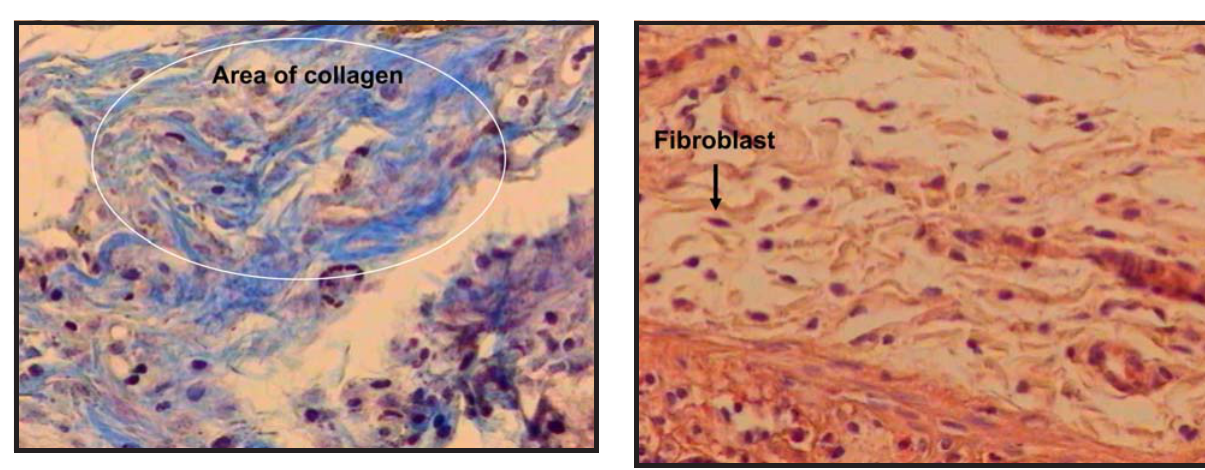
FIGURE 2 – Photomicrograph showing the area of collagen on the colon wall (areas in blue) via Masson’s trichrome staining